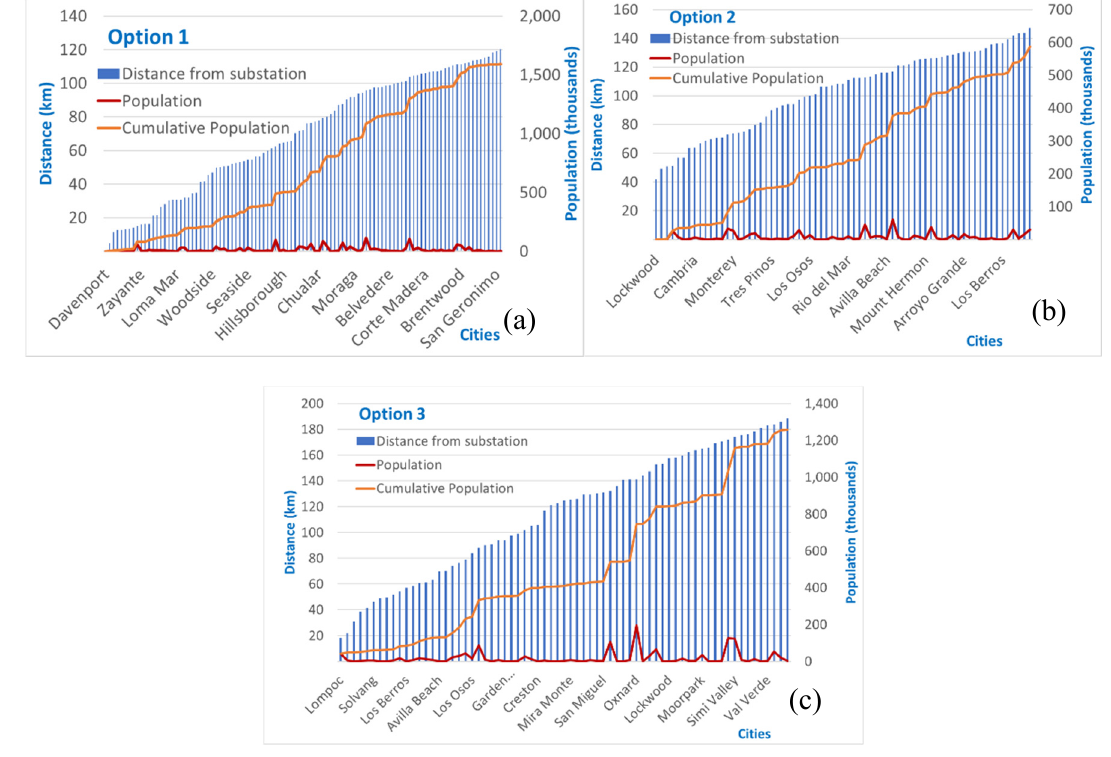
Figure 18. Analysis of distance form onshore substation and population for proposed offshore wind turbines in three locations under consideration. (a) Option 1. (b) Option 2. (c) Option 3.